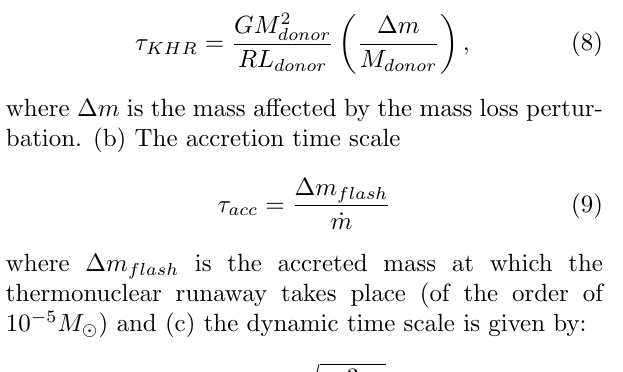
Figure 1: The derivative dR for an imposed mass loss of 10 − 10 M (cid:12) /yr . In this case τ flash 10 5 yr . ≈